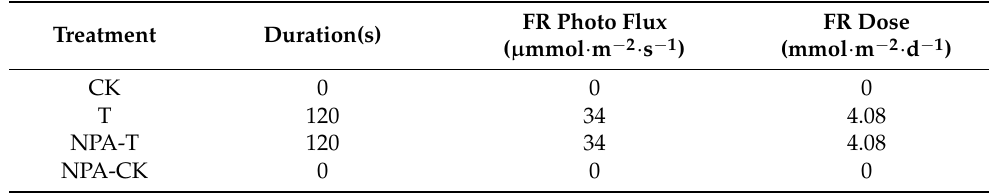
Table 1. Far-red light intensity (photon flux), duration, and applied far-red dose of the end-of-day far-red (EOD-FR)